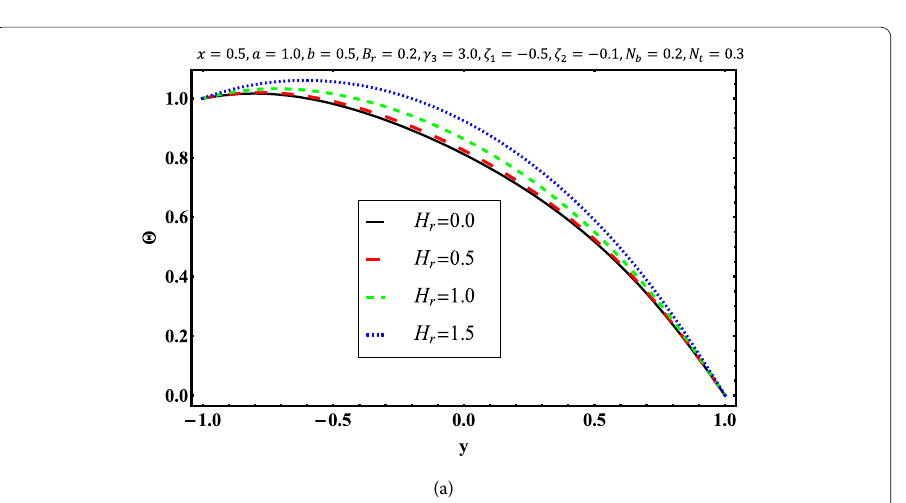
Figure 11 For different values of H r , ( a ) temperature distribution Θ and ( b ) concentration distribution Ω